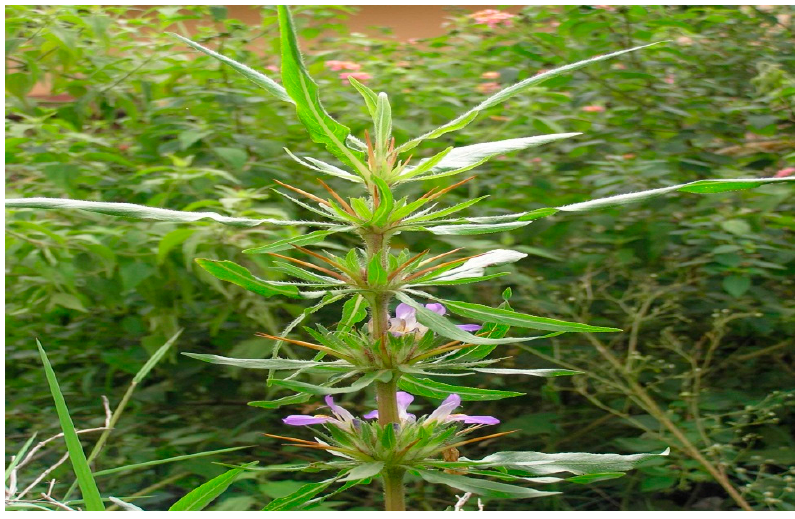
Figure 11. Image of Asteracantha longifolia plant. Source: [123].